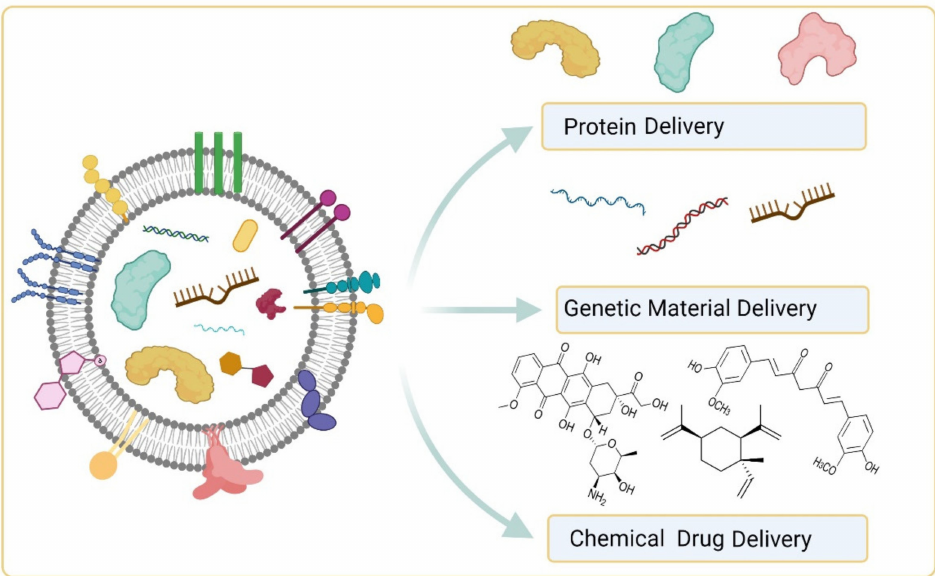
Figure 3. EVs are nanoscale structures with excellent biocompatibility and the ability to trans- port/deliver many different types of proteins, genetic material, and chemical drugs that can be used in cancer